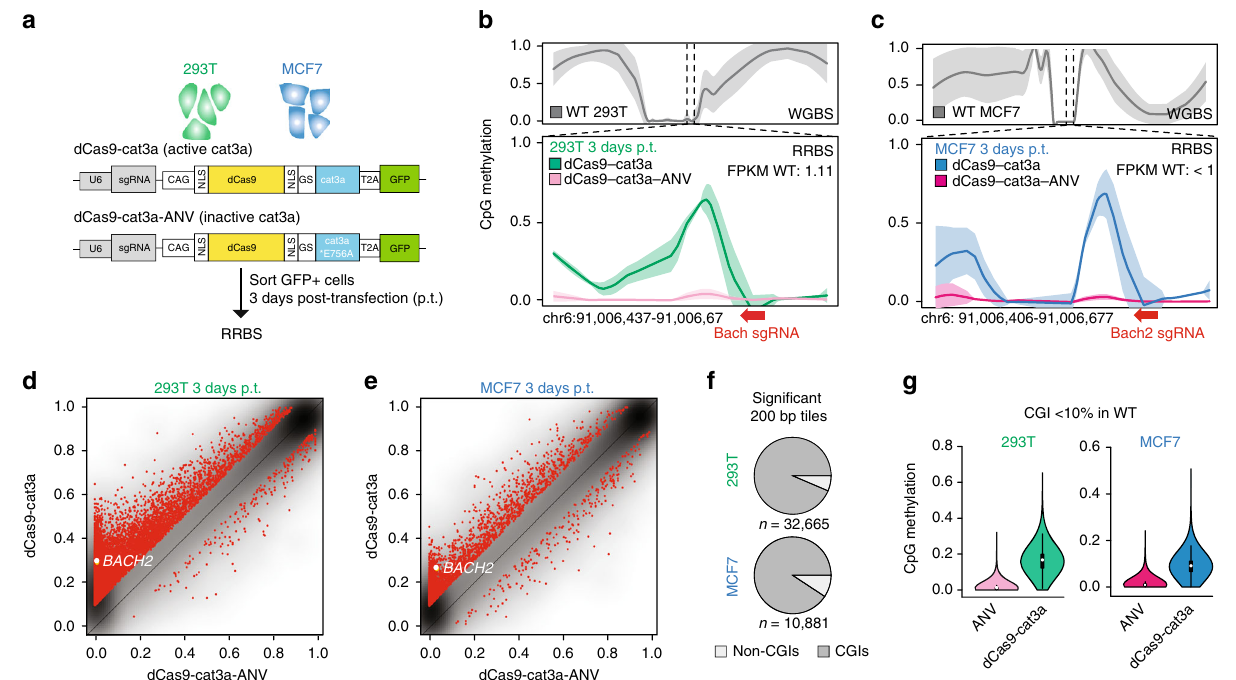
Fig. 3 Global off-target CpG methylation after transient dCas9-cat3a transfection. a 293T human embryonic kidney and MCF7 human breast cancer cells were transfected with pdCas9-DNMT3A-EGFP (Addgene #71666) or pdCas9-DNMT3A-EGFP (ANV) (Addgene #71685) with an sgRNA targeting BACH2 . Cells were collected 3 days post-transfection (p.t.) and RRBS was performed. b Top: loess-smoothed CpG methylation for 293T cells (WGBS) highlighting the location of the BACH2 target within a CpG island. Bottom: the on-target smoothed methylation levels (RRBS) for 293T cells transfected with dCas9-cat3a or dCas9-cat3a-ANV 3 days p.t. The bold line indicates the mean methylation level with standard deviation shown by shaded fi ll. The position and orientation of the Bach2 sgRNA is indicated with a red arrow. c same as in b but for MCF7 cells. d Smooth scatter plot displaying mean methylation over 200 bp tiles in dCas9-cat3a and dCas9-cat3a-ANV transfected 293T cells 3 days p.t. with the Bach2 sgRNA (total tiles: 219,949). Red dots indicate tiles with signi fi cant changes in methylation (adj. p -value < 0.05 ( t -test) and difference > 10%, signi fi cant tiles: 32,665). The BACH2 locus is signi fi cant and highlighted as a white dot. e Same as in d but for MCF7 cells (total tiles: 200,157; signi fi cant tiles: 10,881). f The proportion of signi fi cantly differentially methylated 200 bp tiles that are located within CpG islands (CGIs) for 293T and MCF7 cells. g Methylation levels for CGIs that have < 10% methylation in WT cells shown for dCas9 – cat3a – ANV and dCas9 – cat3a transfected 293T/MCF7